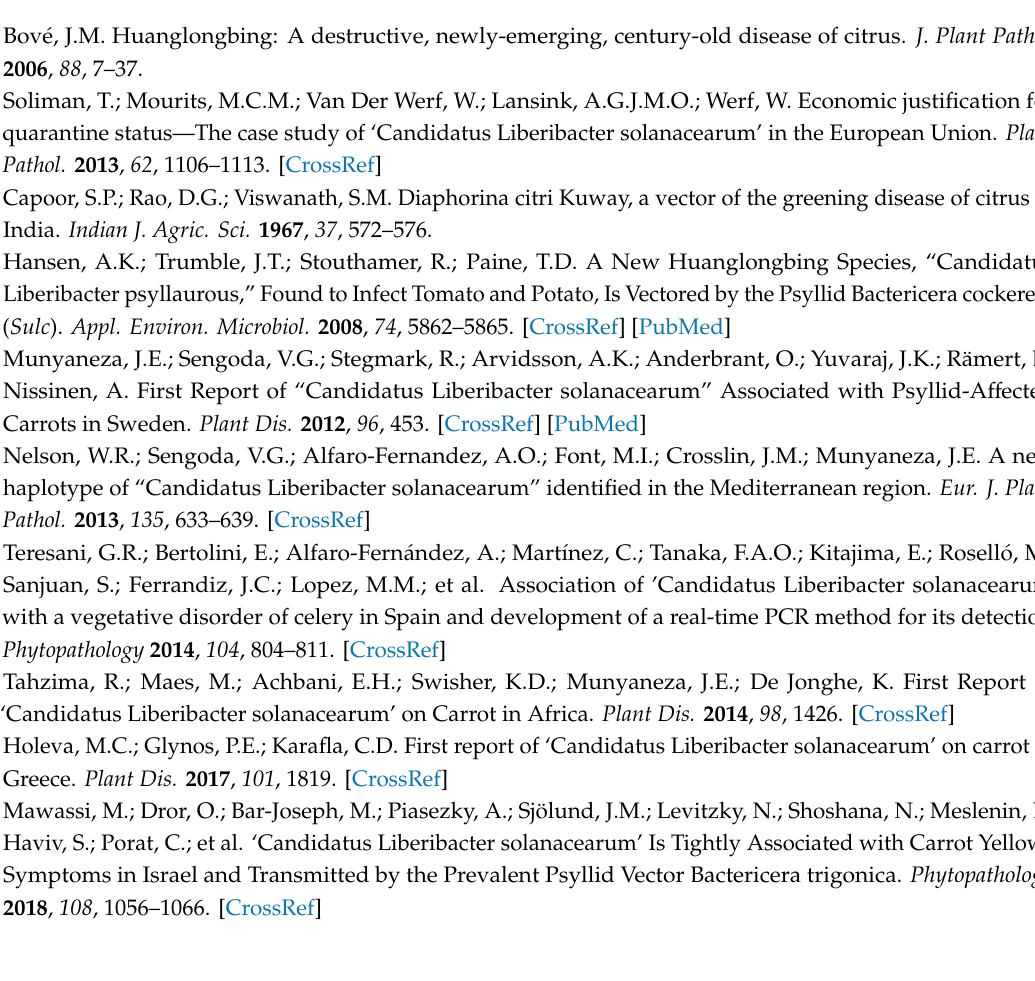
Figure S1: ( A ) GO functional classification of DEGs between CLso infected and uninfected midguts of B. trigonica ; ( B ) Pathway enrichment statistics of DEGs between CLso infected and uninfected midguts of B. trigonica . Accession numbers: The transcriptome de novo assembly generated in this study is available at the DDBJ / EMBL / GenBank database under the BioProject ID: PRJNA561752. Accession number of the raw reads are SRR10019128 and the transcriptome assembly is